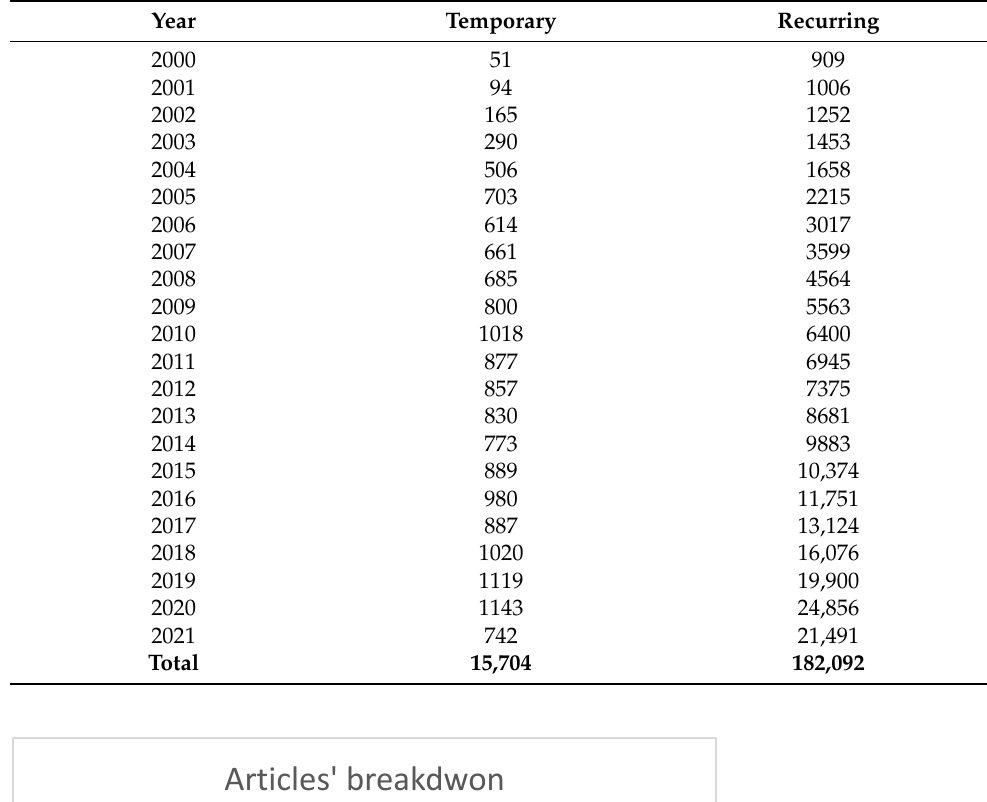
Table 2. Breakdown of the articles based on the publication year.